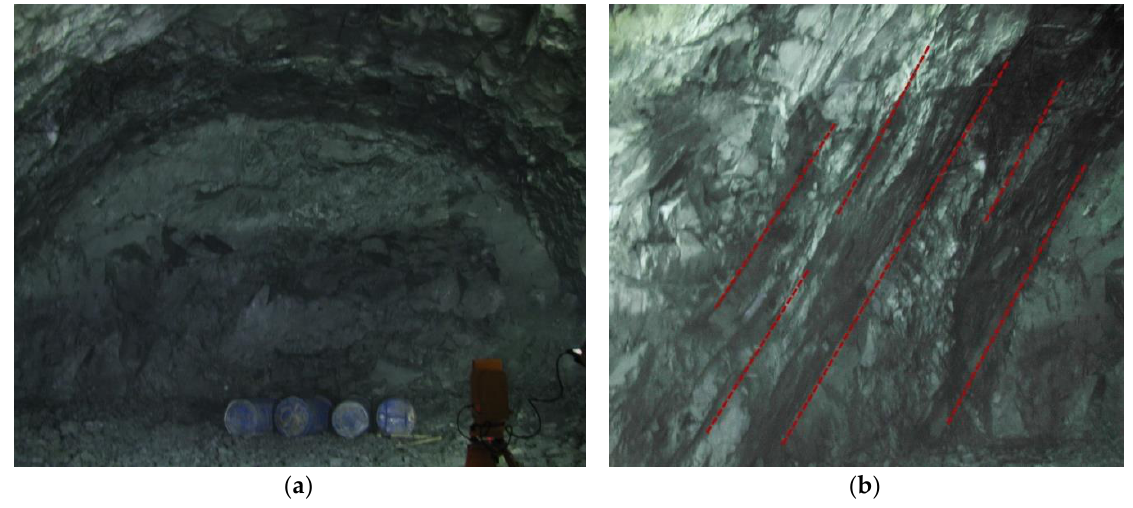
Figure 8. ( a ) Tunnel face of Zigaojian Tunnel. ( b ) Visible bedded joints.